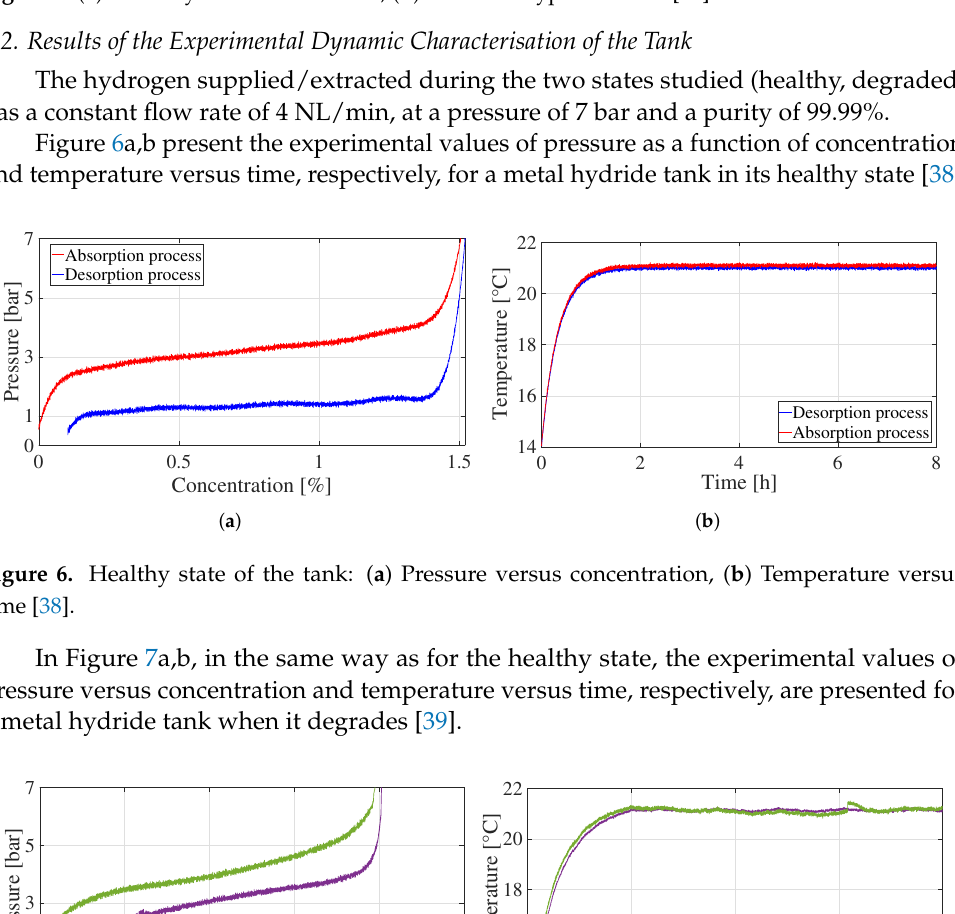
Figure 5. ( a ) Metal hydride tank studied; ( b ) FCEV Mobypost vehicle [20].